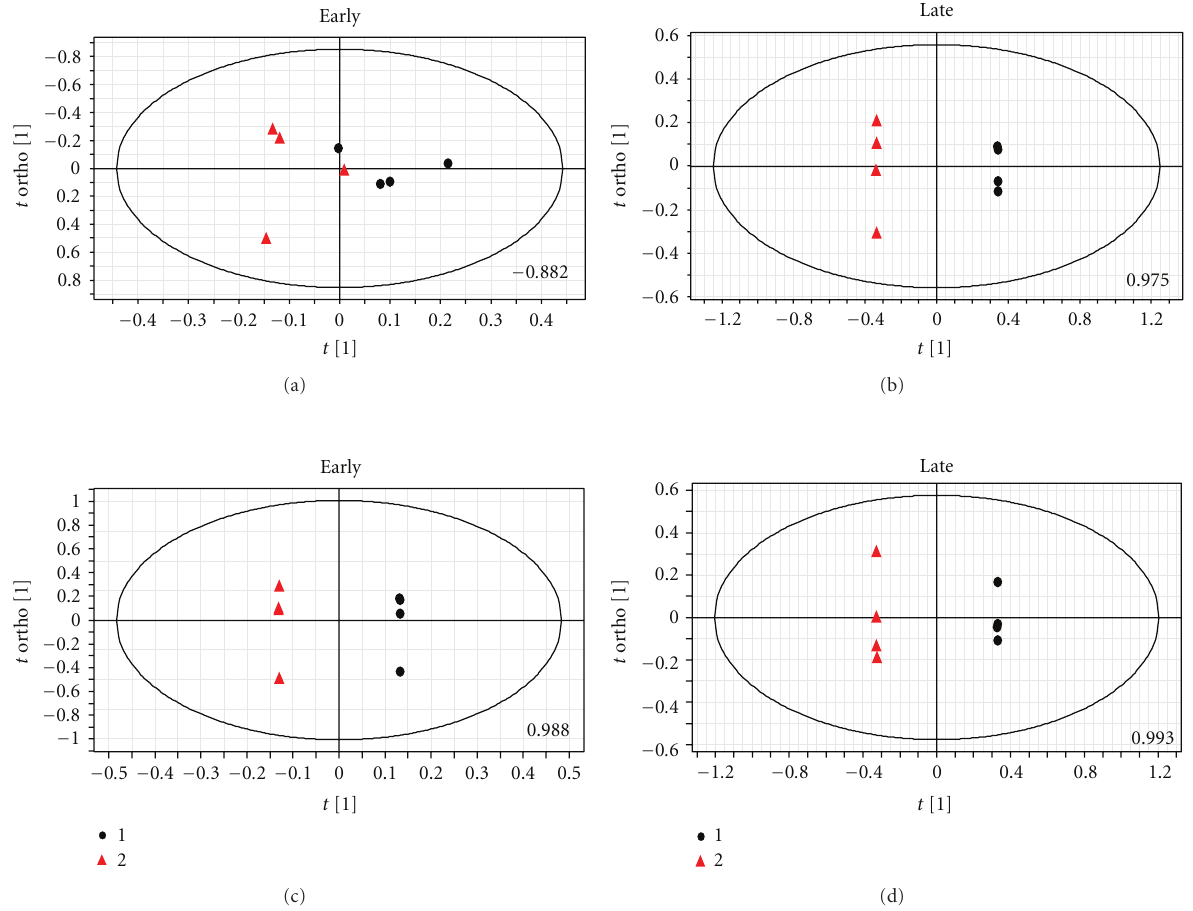
Figure 1: OPLS-DA scores plot based on the 1 H NMR metabolic profile of the liver. The experiments consisted of 12 male and 12 female mice. Eight male and 8 female mice were injected with P. berghei ANKA. On day 5, 4 infected males, 4 infected females, 2 control males, and 2 control femaleswere sacrificed, and the liver is extracted with perchloric acid (early-stage of infection). Again on day 13 (late-stage infection). A/B, early- and late-stage infection males are compared with male controls; C/D, early- and late-stage infection females are compared with female controls. In each plot, the Q 2 (cum) is shown at the bottom. The red triangle—profile of the infected animals and the black dots—the control